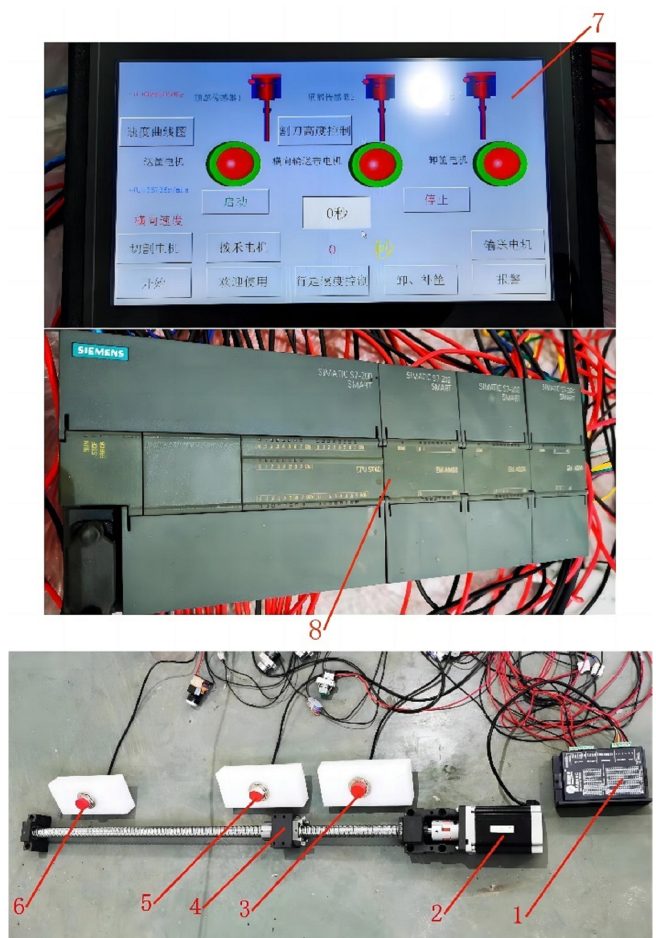
Figure 11. Cutter height off the ground automatic control system device based on incremental PID. 1. Stepper motor driver 2. Stepper motor 3. Left limit proximity switch 4. Slider 5. Zero limit proximity switch 6. Right limit proximity switch 7. Touch screen 8.